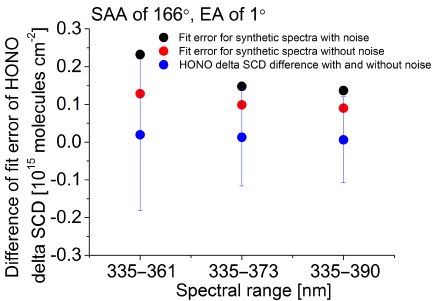
Figure 12. Comparison of the averaged fit errors of the HONO delta SCDs for synthetic spectra with and without noise (black and red dots), and the averaged differences of the HONO delta SCDs de- rived from the two synthetic spectra (blue dots). The error bars in- dicate the corresponding standard deviations of the